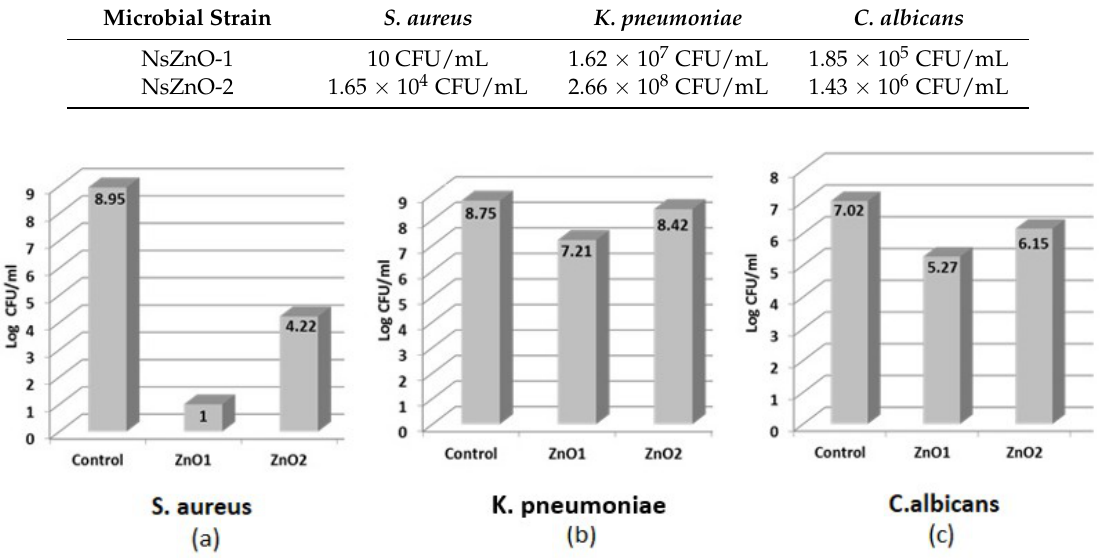
Figure 6. Comparison of antibacterial activities of NsZnO-1 and NsZnO-2 against S. aureus ( a ), K. pneumoniae ( b ), and C. albicans ( c ) expressed in Log CFU/mL.